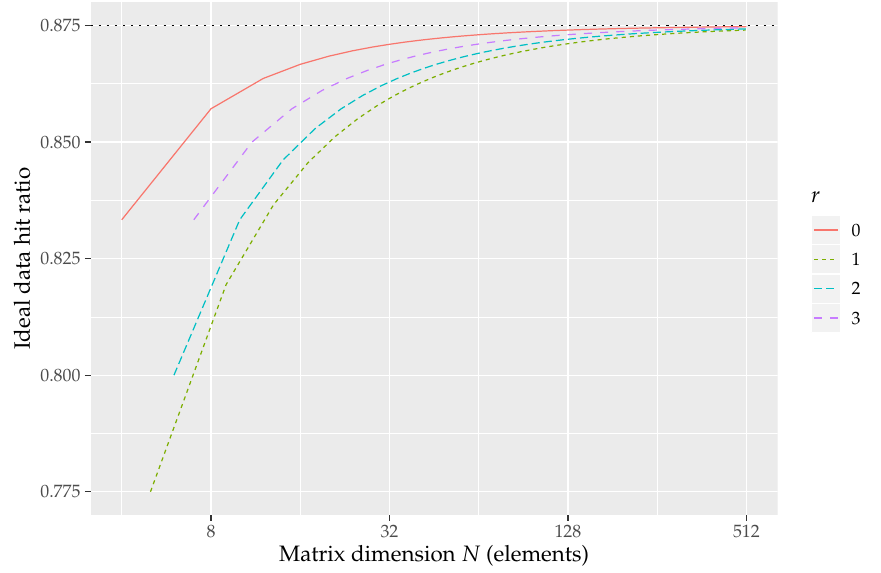
Figure 2. Ideal data hit ratios for L = 4 elements with different r values. Black dotted line shows the upper bound hit ratio of eq. 1.